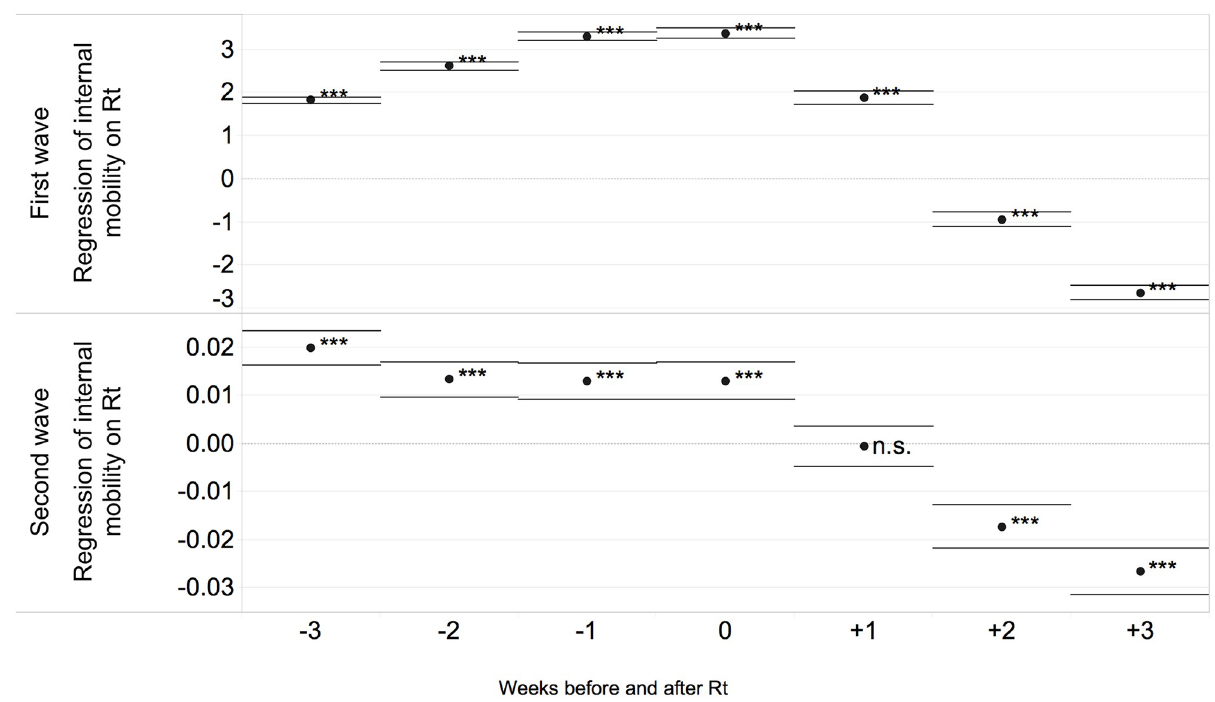
Fig 6. Regression coefficients with shifts of internal mobility of 3 weeks before and after the reference week of